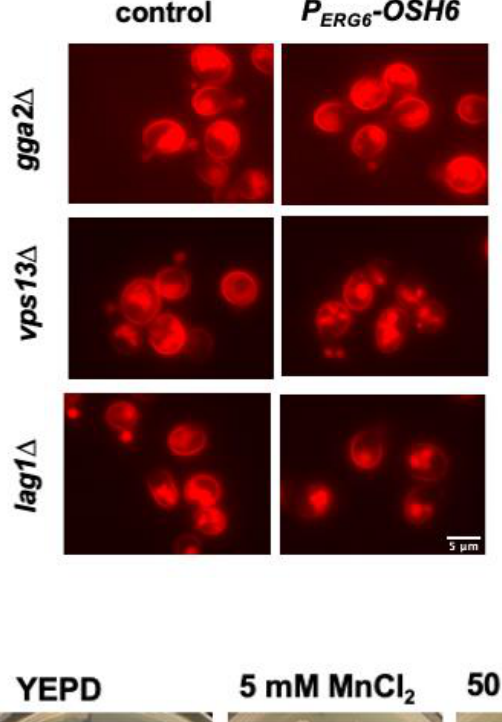
FIGURE 5: Up-regulated Osh6 works through the TGN-LE traf- ficking pathway. (A) The Pma1- mCherry distribution in the indi- cated strains. The respective con- trol for each indicated mutant is shown on the left with Pma1- mCherry. P ERG6 - OSH6 side means P ERG6 - OSH6 Pma1-mCherry carry- ing the indicated mutations listed on the left. Early log phase cells grown in YEPD were photo- graphed. (B) Comparison of growth on metal-containing me- dia. Five l of 10-fold serially di- luted cells (starting from the left 0.1 OD 600 /ml) were spotted on YEPD or YEPD with the indicated salts and grown at 30 ℃ for two